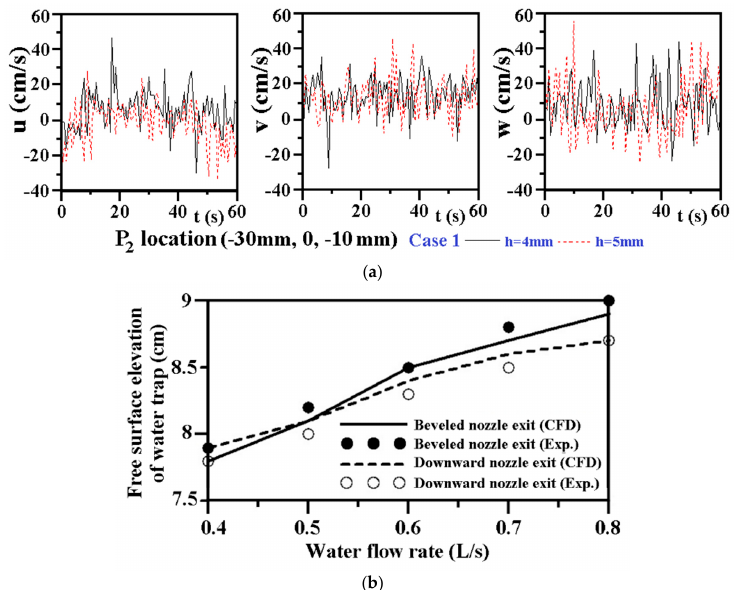
Figure 3. ( a ) Simulated temporal u , v , and w variations at location P2 using the grids of h = 4 and 5 mm; and ( b ) comparisons of water level elevation from drum bottom at water flow rates of 0.4, 0.5, 0.6, 0.7 and 0.8 L/s between numerical predictions and experimental measurements.